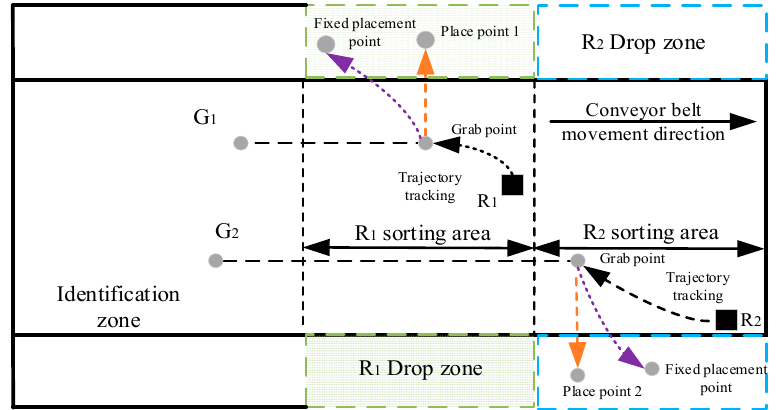
Figure 12. Schematic diagram of different placement points in fixed space.